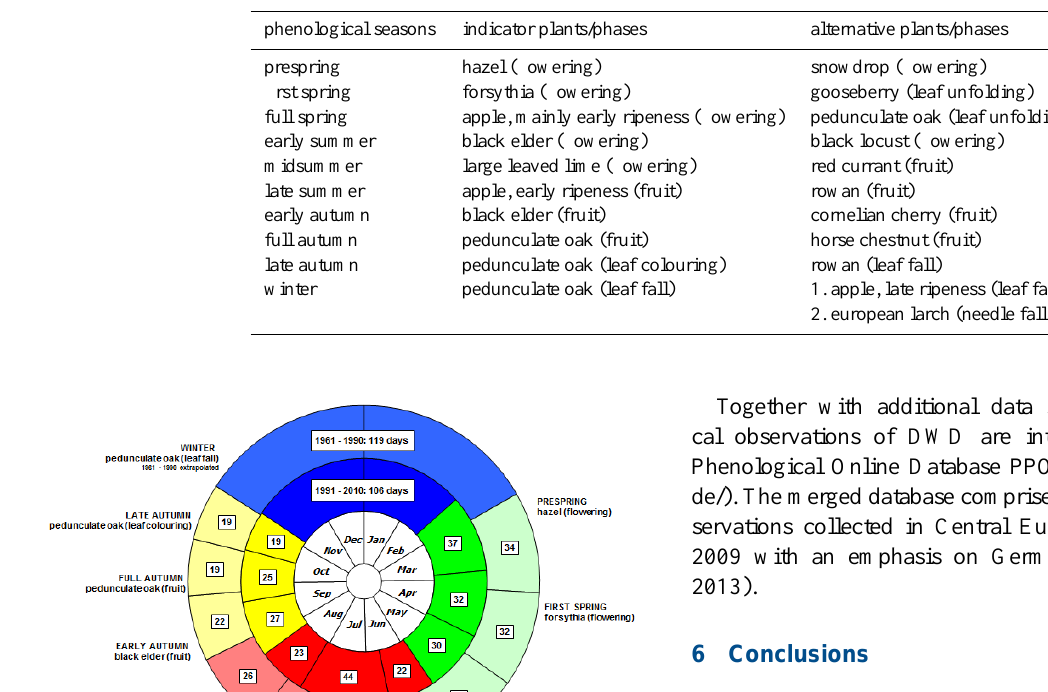
Table 3. Indicator phases used to define the phenological seasons. Each season begins with an indicator phase and ends with the beginning of the next season. The alternative phase can be used if the indicator phase is not available.